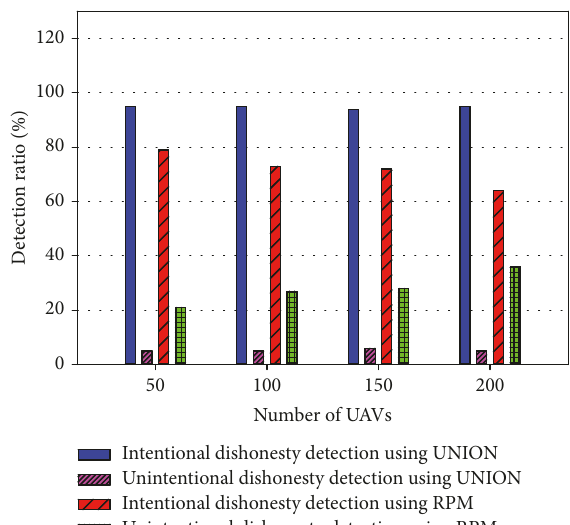
Figure 8: 𝑈𝑁𝐼𝑂𝑁 packet loss ratio compared to 𝑅𝑃𝑀 , 𝐶𝐴𝑇𝑟𝑢𝑠𝑡 , and 𝑇 - 𝐶𝐿𝐴𝐼𝐷𝑆 in the presence of 25% dishonest UAVs.